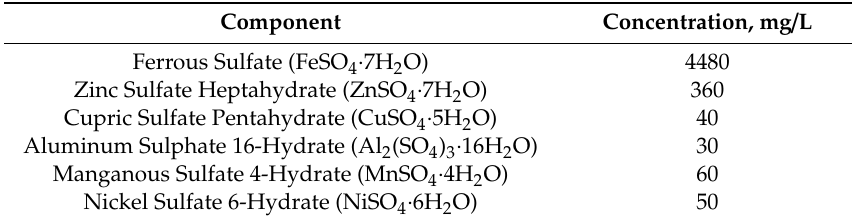
Table 3. The composition of the solution of heavy